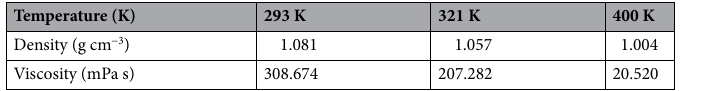
Table 5. The densities and viscosities of deep eutectic solvents at 293, 321and 400 K.